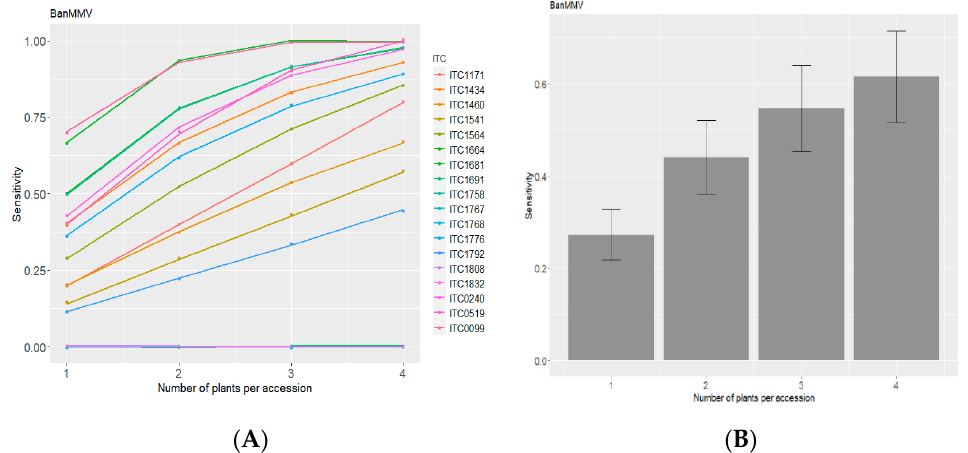
Figure 2. ( A ) Percentage of sensitivity of diagnostic of BanMMV from in vitro plants using 1, 2, 3, and 4 plants per combination for each accession. ( B ) Comparison of average sensitivity between combinations regardless of accessions. Error bar represent +/ − standard deviation.